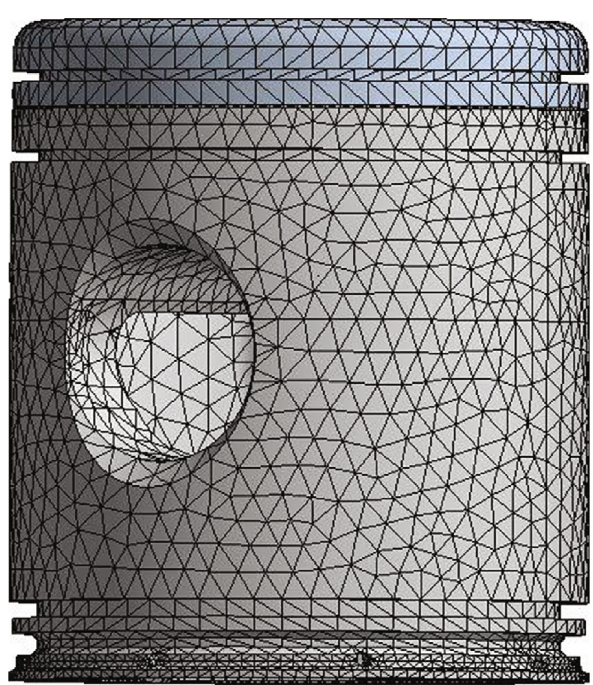
Figure 2: The meshing of the